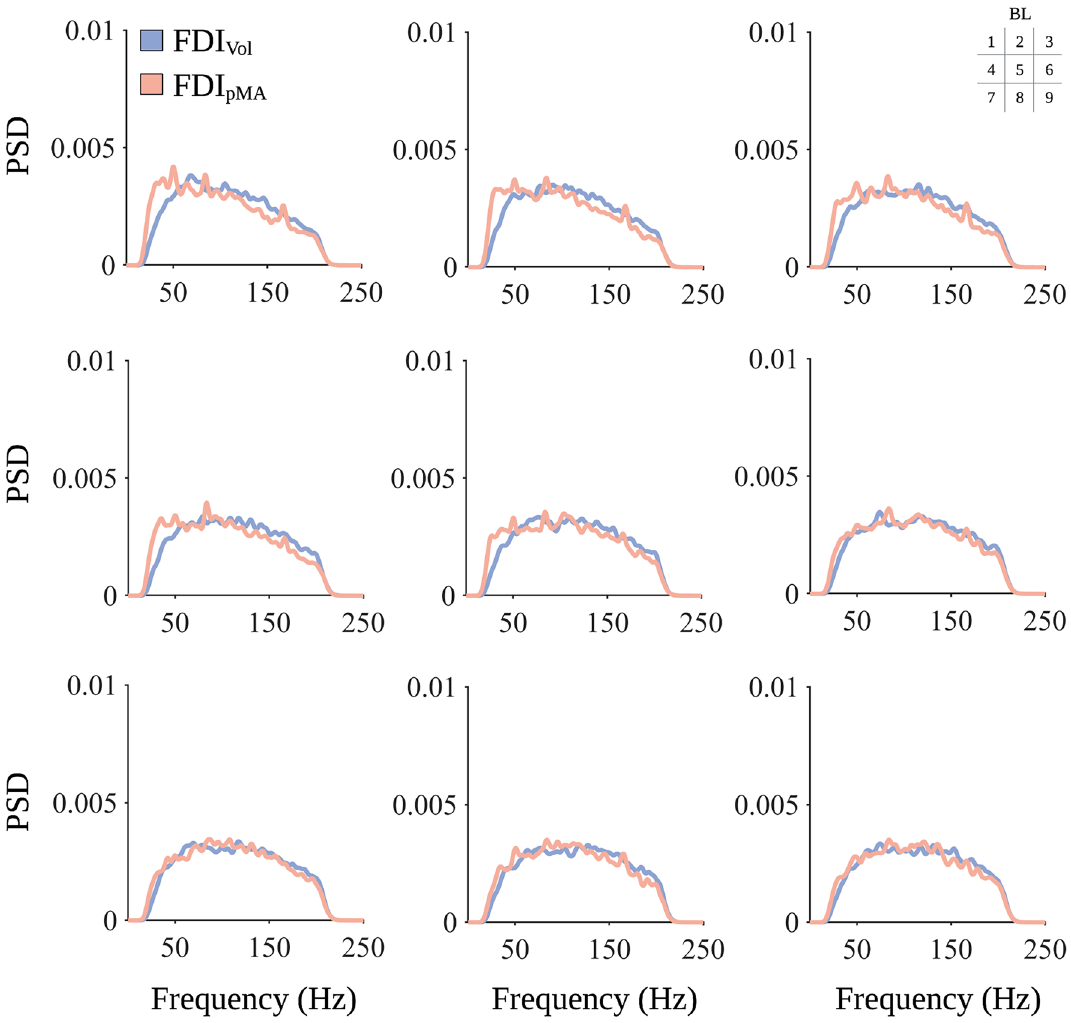
Figure 2. Power spectral density (PSD) for FDI Vol and FDI pMA . Displayed are blockwise PSDs averaged across all participants estimated according to Welch’s method. Each subplot represents averaged PSDs for one block (1–9), the order of which is highlighted in the matrix legend in the upper-right